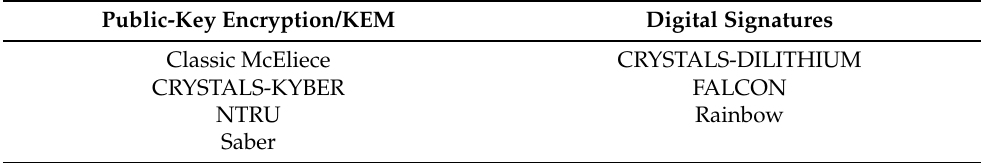
Table 1. The current finalists of the NIST standardization process.